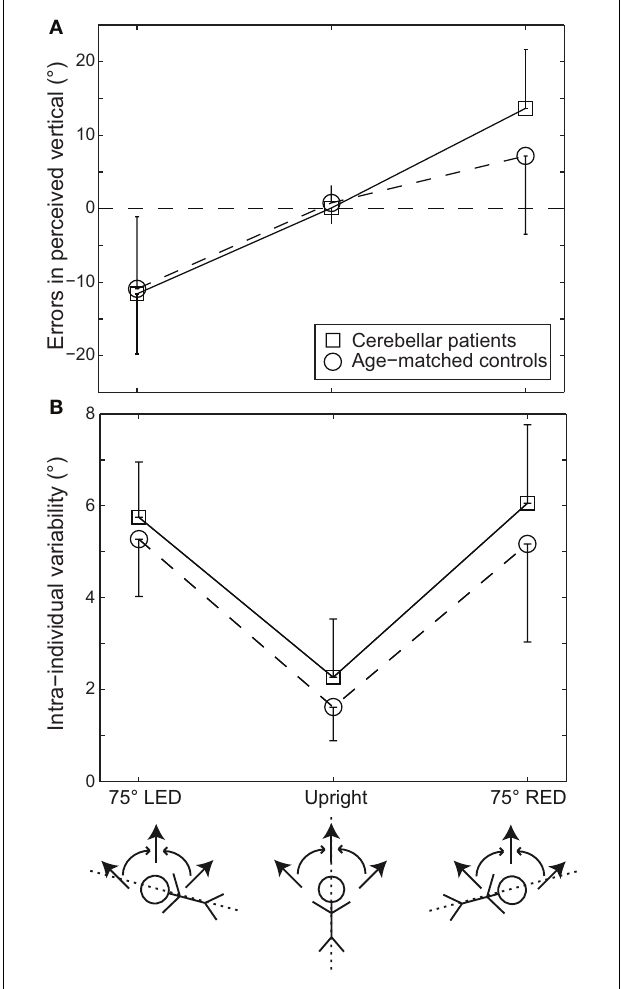
FIGURE 1 |Average errors ( ± 1 SD) in perceived vertical (A) and average intra-individual SVV variability ( ± 1 SD) (B) are plotted against whole-body roll position both for the cerebellar patients (squares) and the age-matched healthy controls (circles). The direction (indicated by the curved arrows) of arrow adjustments (straight arrows: clockwise vs. counter-clockwise), as illustrated below the x -axis for all roll positions (upright, 75˚ left-ear-down or LED, and 75˚ right-ear-down or RED) tested was